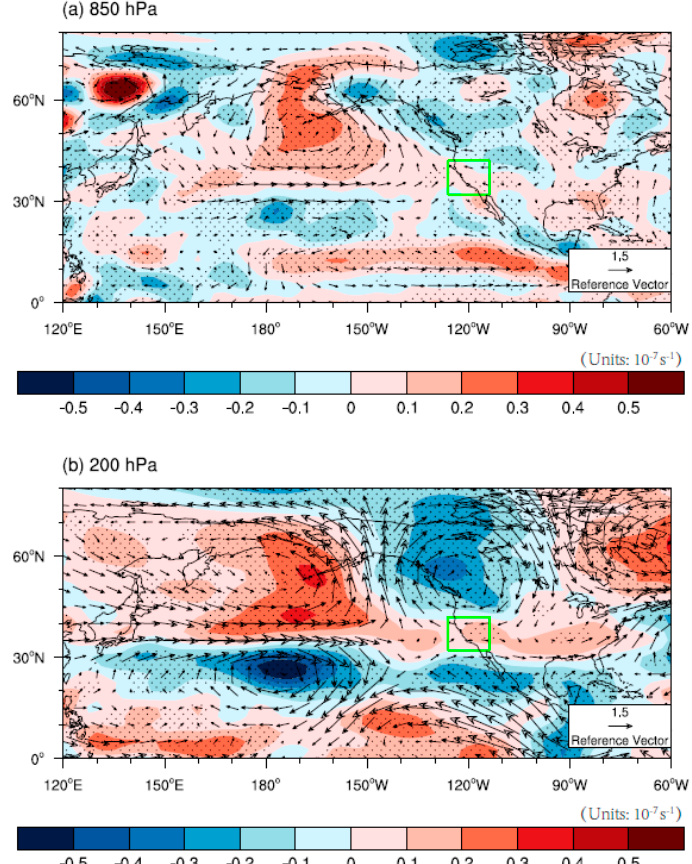
. Figure 10. Relative vorticity (shading; 10 − 7 s − 1 ) and horizontal velocity (vector; m/s) at 850 hPa ( a ) and 200 hPa ( b ) in winter regressed to the box-averaged SST (the left red box in Figure 9c). The green box represents the selected California area. Areas with dots exceed the 90% confidence